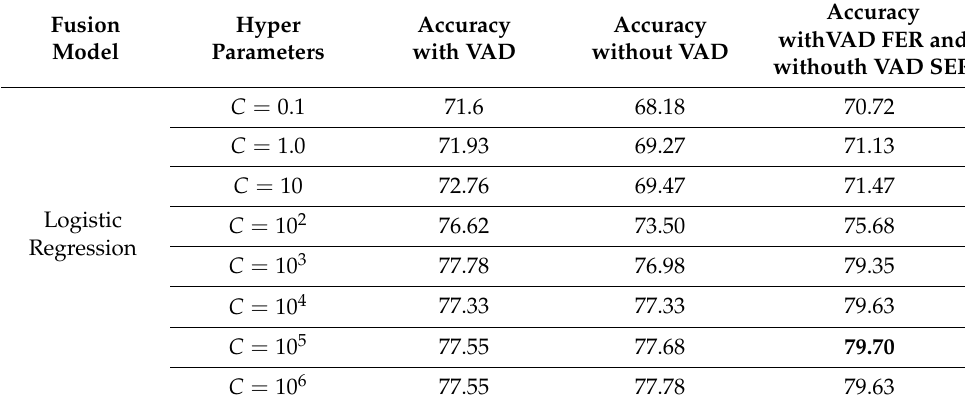
Table A3. Tested models for applying fusion strategy on the combined posteriors of the top models for each modality. In bold, the best models of each type in terms of the